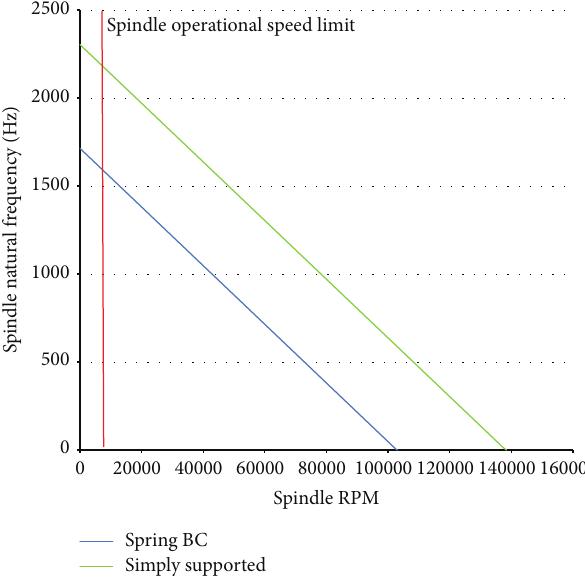
Figure 9: Spindle natural frequency versus spindle RPM; high torque